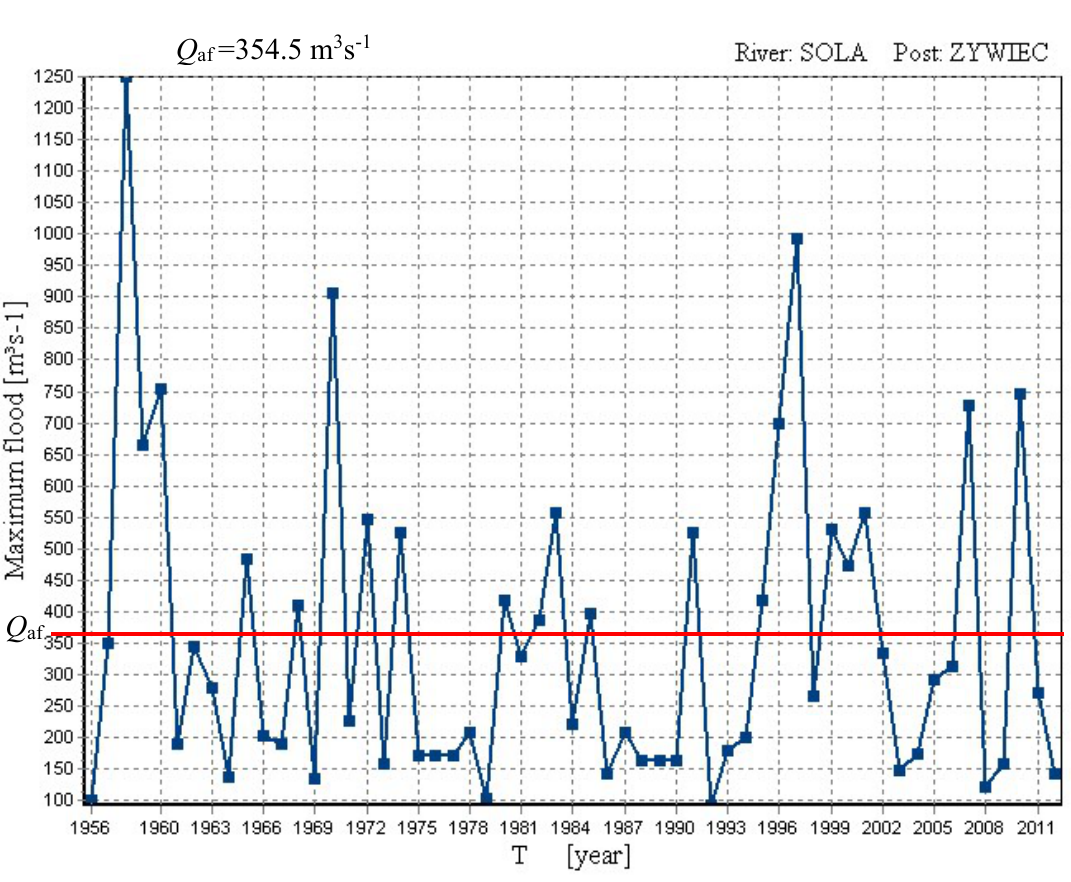
Figure 6. Annual peak flows for Zywiec post on the Sola River during 1956–2012.